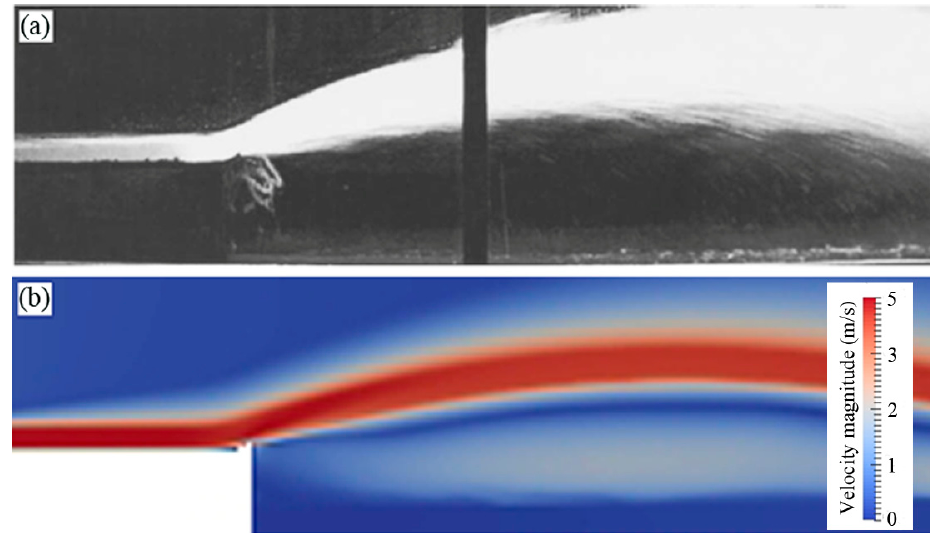
Figure 6. Visual comparison between the ski jump jets for R = 0.10 m, β = 40°, h 0 = 0.05 m, F 0 = 10 (test no. 29 in Table 1: ( a ) physical experiment [15] (reproduced with permission from ASCE); ( b ) numerical results of the present study (note: the darkest red color represents velocity magnitudes of 5 m/s and larger).